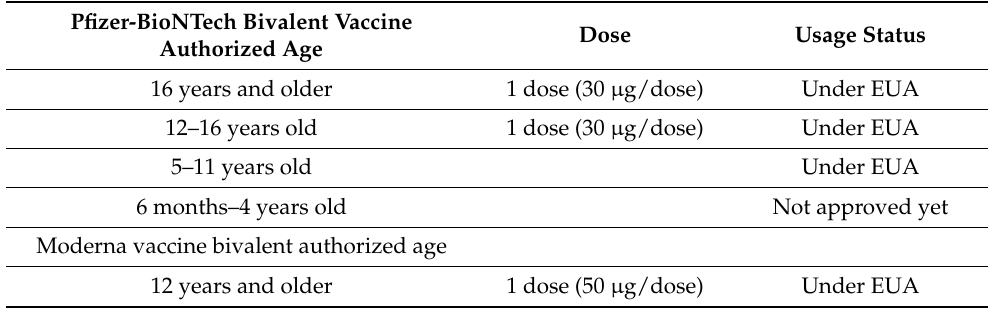
Table 4. Bivalent Vaccines approved for children so far are listed